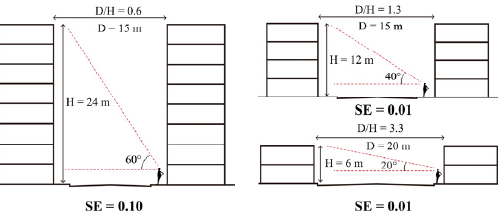
Figure 11. Variation of SE with different D/H ratio, street space form, and pedestrian perspective.